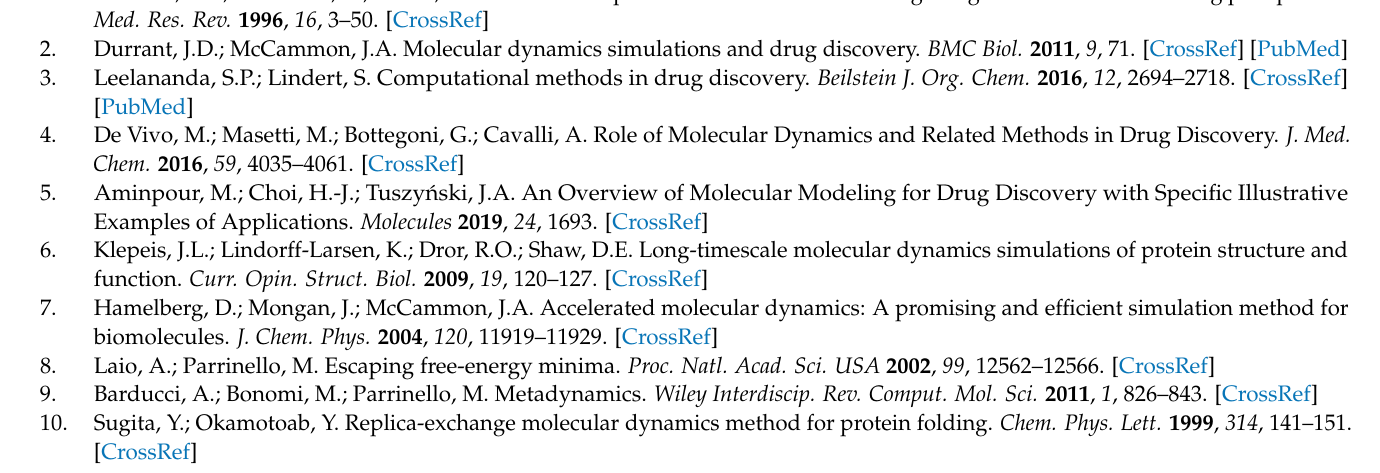
fication of the nine secondary structure regions (C 5 , P II , α D , β 2, C 7axial , α L , α ’, α R and C 7eq ) in the Ramachandran space by J. Rubio-Martinez et al., Figure S3: Gibbs free energies in the Ramachandran space of the blocked Tyr 2 tripeptide, Figure S4: Gibbs free energies in the Ramachandran space of the blocked Lys 2 tripeptide, Figure S5: Gibbs free energies in the Ramachandran space of the blocked His 2 tripeptide, Figure S6: Gibbs free energies in the Ramachandran space of the blocked Glu 2 tripeptide, Figure S7: Energy distributions of the blocked Tyr 2 tripeptide, Figure S8: Energy distributions of the blocked Cys 2 tripeptide, Figure S9: Energy distribution of the 1–4 and long-range electrostatics of the backbone and side chain atoms of the blocked Tyr 2 tripeptide, Figure S10: Energy distribution of the 1–4 and long-range electrostatics of the backbone and side chain atoms of the blocked Cys 2 tripeptide, Figure S11: Energy distributions of the blocked His 2 tripeptide, Figure S12: Energy distribution of the 1–4 and long-range electrostatics of the backbone and side chain atoms of the blocked His 2 tripeptide, Figure S13: Energy distributions of the blocked Glu 2 tripeptide, Figure S14: Energy distribution of the 1–4 and long-range electrostatics of the backbone and side chain atoms of the blocked Glu 2 tripeptide, Figure S15: Gibbs free energies in the side chain-orientation space of the blocked Lys 2 tripeptide, Figure S16: Gibbs free energies in the side chain-orientation space of the blocked Tyr 2 tripeptide, Figure S17: Gibbs free energies in the side chain-orientation space of the blocked Cys 2 tripeptide, Figure S18: Gibbs free energies in the side chain-orientation space of the blocked Glu 2 tripeptide, Figure S19: Gibbs free energies in the side chain-orientation space of the blocked Asp 2 tripeptide, Figure S20: Distribution of the atomic distance between the atoms of the side chain selected for the construction of the θ dihedral angle, Table S1: Partial charges of the protonated and deprotonated forms of the Glu and Asp amino acids in CMD and CPHMD simulations, Table S2: Partial charges of the protonated and deprotonated forms of the Lys, Tyr, Cys and His amino acids in CMD and CPHMD simulations, Table S3: Averages and standard deviations of the interatomic distance using the selected atoms at the extreme of the side